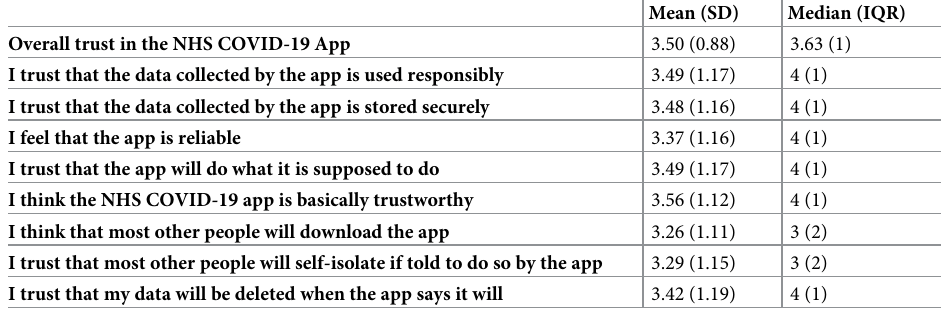
Table 2. Trust in the NHS COVID-19